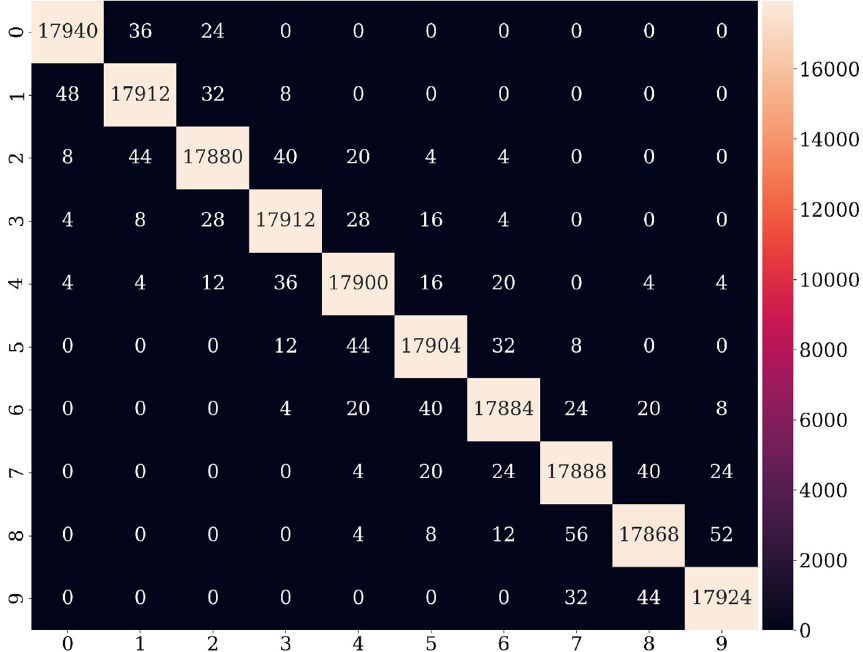
Figure 5. The confusion matrix corresponding to classification performed using a decision tree trained on a dataset with 10-component output vectors. The data correspond to ten transmission eigenchannels of three devices with three different scattering strengths N s . This classification allows for identification of the eigenchannel independent of the disorder strength. The maximum value in any cell can be